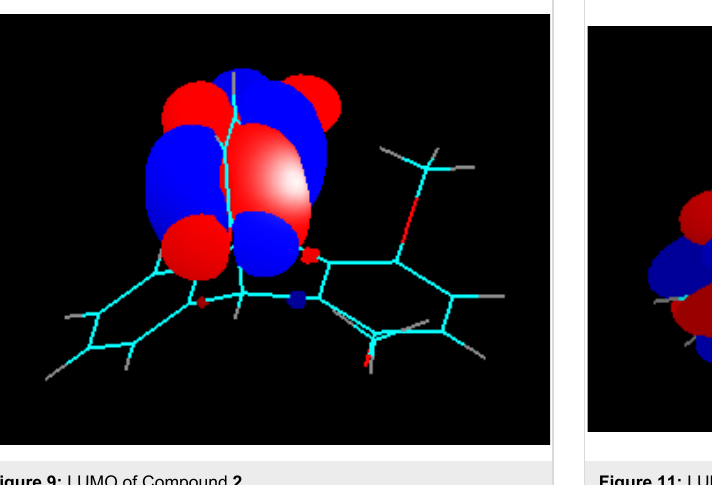
Figure 9: LUMO of Compound 2 .